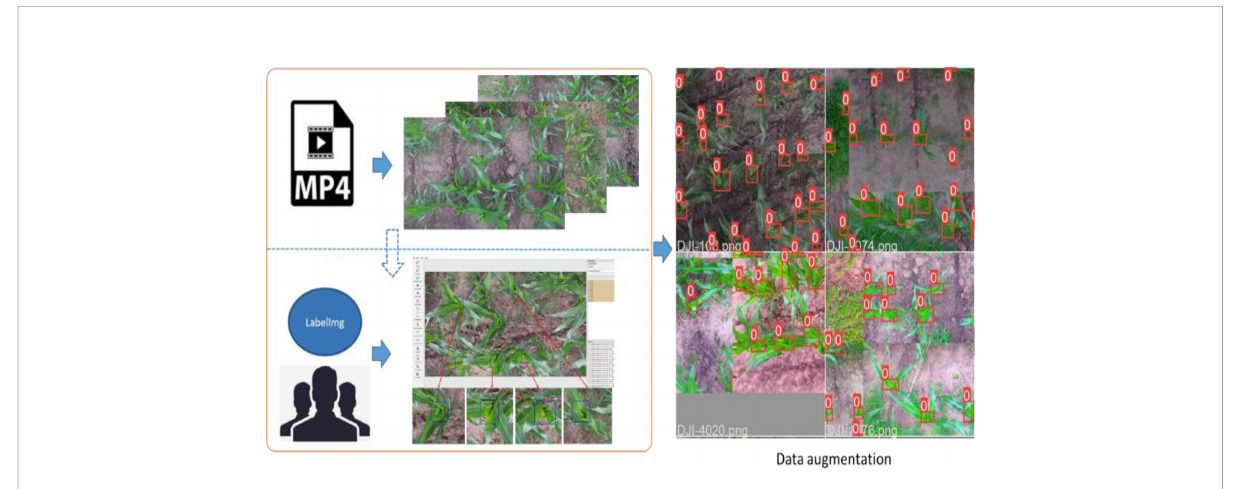
FIGURE 1 Data processing fl ow and data enhancement